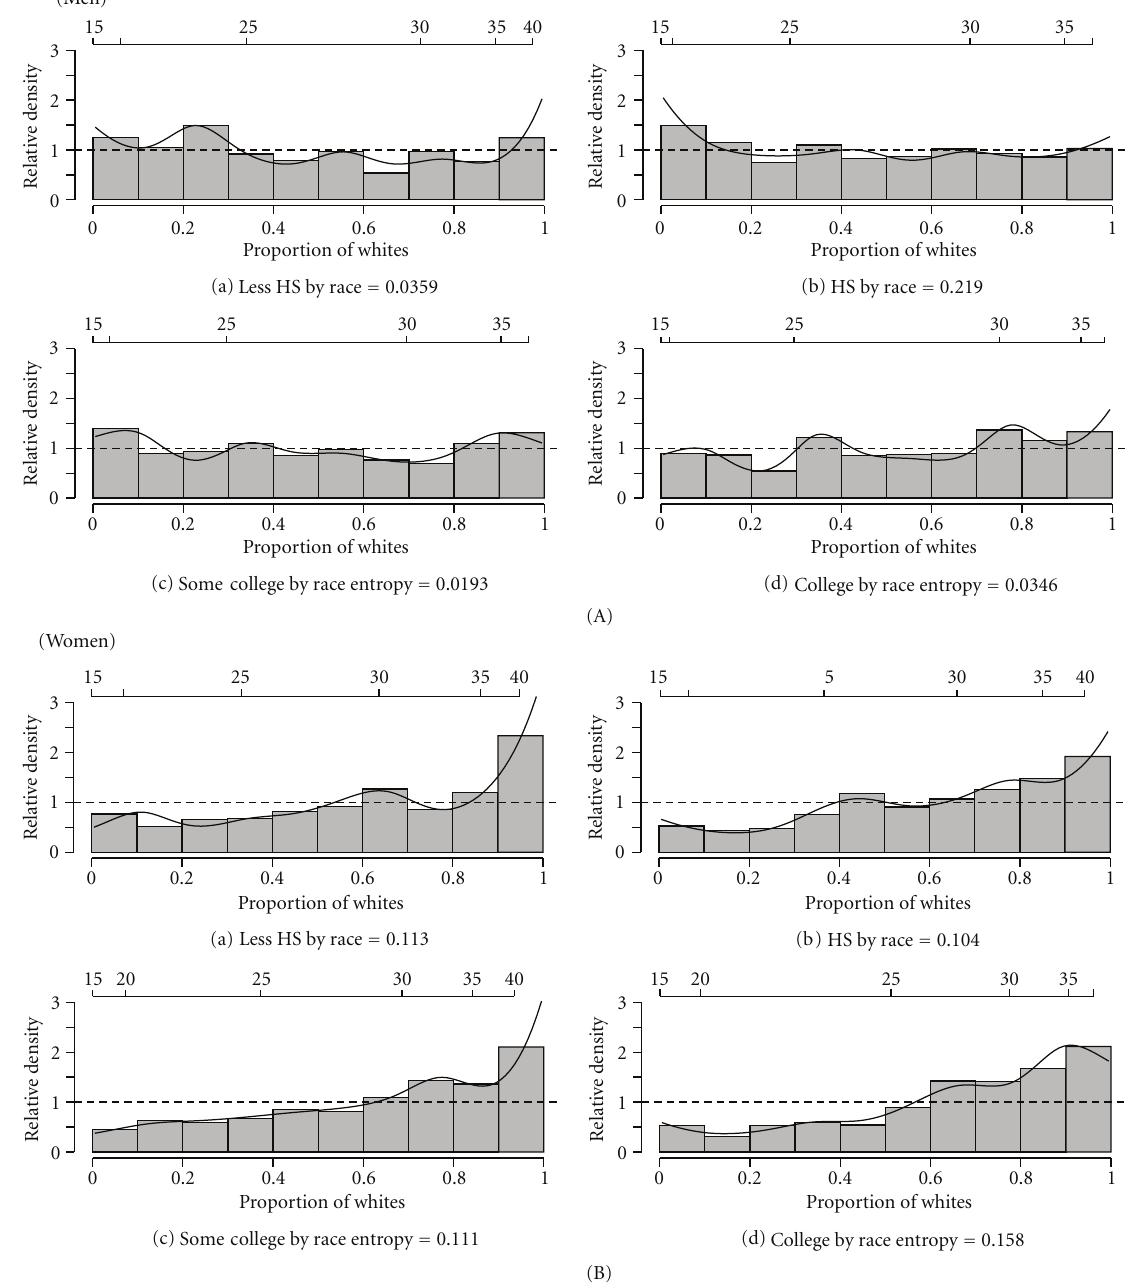
Figure 5: Relative body mass index distributions (1999–2006) between men (A) and women (B) between non-Hispanic Blacks compared to non-Hispanic Whites by (a) those with less than a high school diploma; (b) those with a high school diploma or GED; (c) those with some college education; (d) those with a college degree or more. Deciles chart superimposed on relative densities. Data from the National Health and Nutrition Examination Survey.